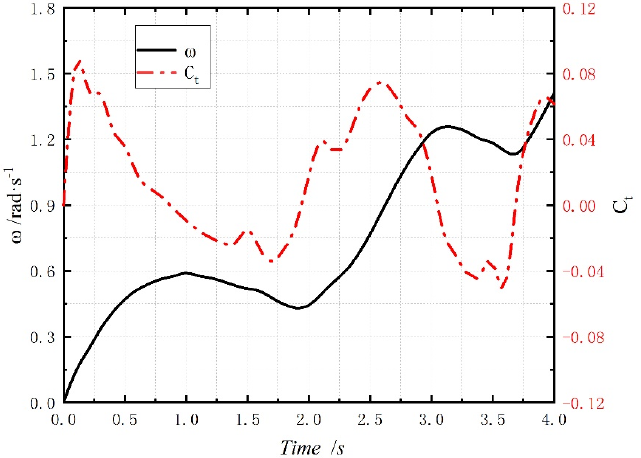
Figure 9. Startup characteristics.